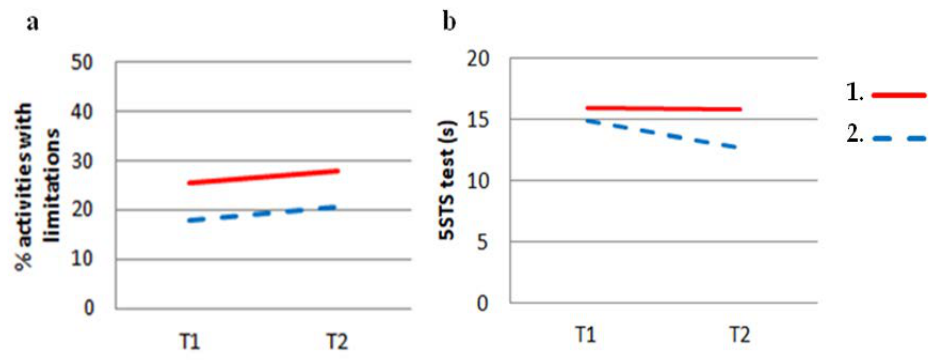
8 of 12 Figure 2. Receiver operating characteristic curves comparing the final clinical pulmonary model and final non-pulmonary model as predictors of poor 6MWT performance (<350 m). 3.2. Temporal Evolution of Relevant Non-Pulmonary Predictors over 2 Years